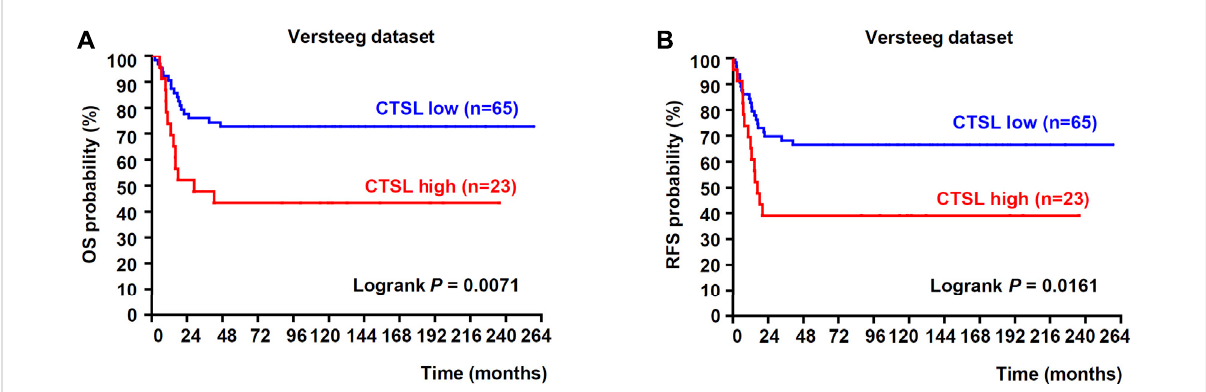
FIGURE 1 Upregulation of CTSL correlated with poor prognosis in patients with NB (A) Kaplan-Meier analysis of overall survival (OS) was determined according to CTSL expression in 88 NB samples from Versteeg dataset (B) Recurrence-free survival (RFS) was also determined according to CTSL expression from Versteeg dataset. Statistical analysis was carried out using a log-rank test.